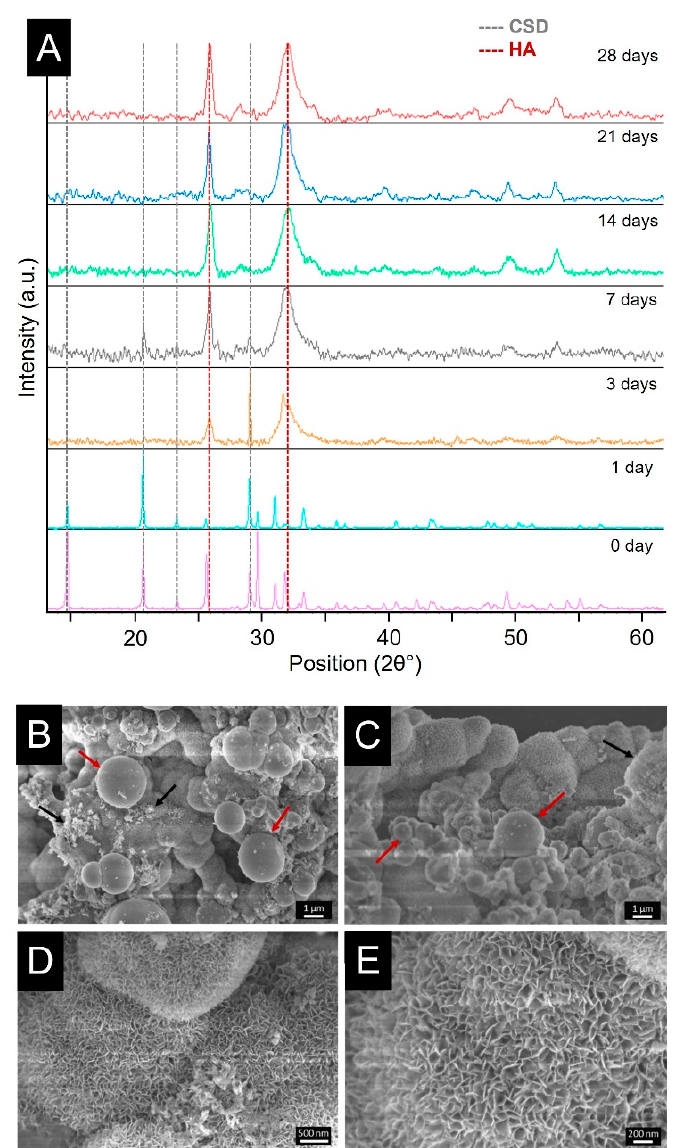
Figure 6. Bioactive behavior assessment of 75CSH/20Sr-MBG-SG/5ZrO 2 formulation: ( A ) XRD spectra of delaminated sheets acquired at different immersion times (CSD peaks in grey dotted lines, HA peaks in red ones); ( B – E ) FE-SEM images captured after 28 days of the immersion in SBF; ( B , C ) Agglomerates of newly formed HA (black arrows) and ZrO 2 particles (red arrows) are highlighted (10,000 × ); ( D , E ) Crystalline HA observed at higher magnification (50,000× and 100,000×, respec- tively).